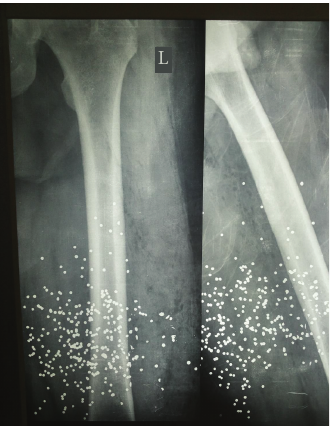
Figure 3: Computed tomography (CT) of the thorax. A small-sized metallic artifact lies at the opening of the right atrium of the heart. No other cardiac or mediastinal